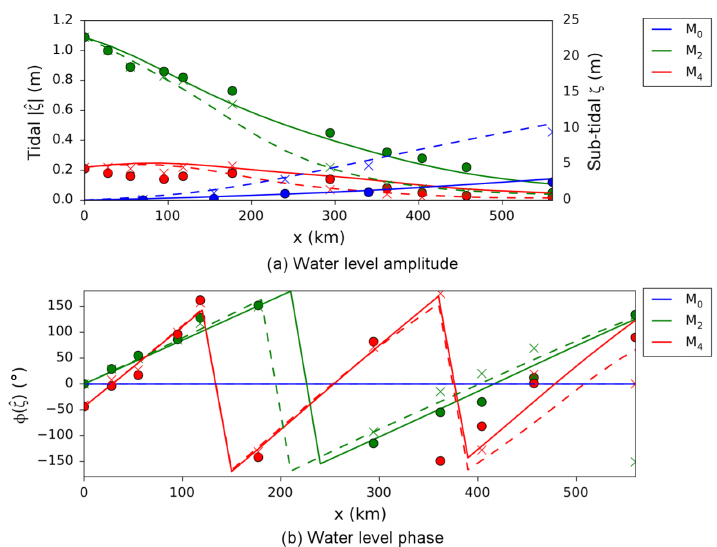
Figure 7. Water level amplitude (a) and phase (b) for the Yangtze case in a dry season situation (solid line and dots) and a wet season situation (dashed line and crosses). The lines represent the sub-tidal (blue), M 2 (green) and M 4 (red) model results. The dots and crosses are measurement data presented by Guo et al. (2016).